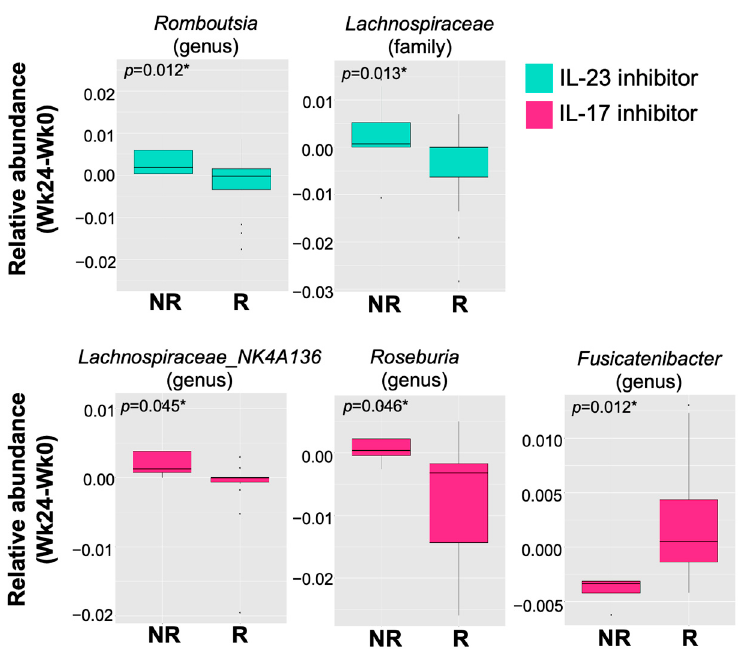
Figure 4. Change in relative abundance of specific gut microbial taxa from the baseline between responders (R) and non-responders (NR) treated with IL-23 (guselkumab) or IL-17 (secukinumab and ixekizumab) inhibitors. The altered level of gut microbiomes at family, genus, or species level at week 24 from the baseline was significantly different between responders and non-responders treated with IL-23 or IL-17 inhibitors. * p <